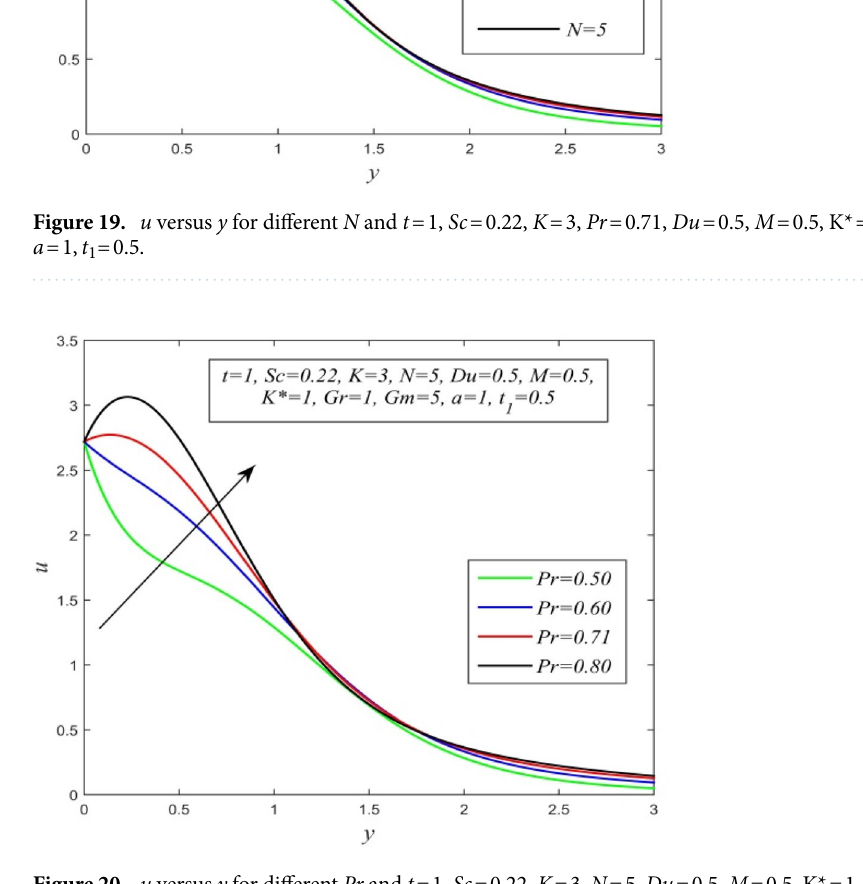
Figure 20. u versus y for different Pr and t = 1, Sc = 0.22, K = 3, N = 5, Du = 0.5, M = 0.5, K* = 1, Gr = 1, Gm = 5, a = 1, t 1 =